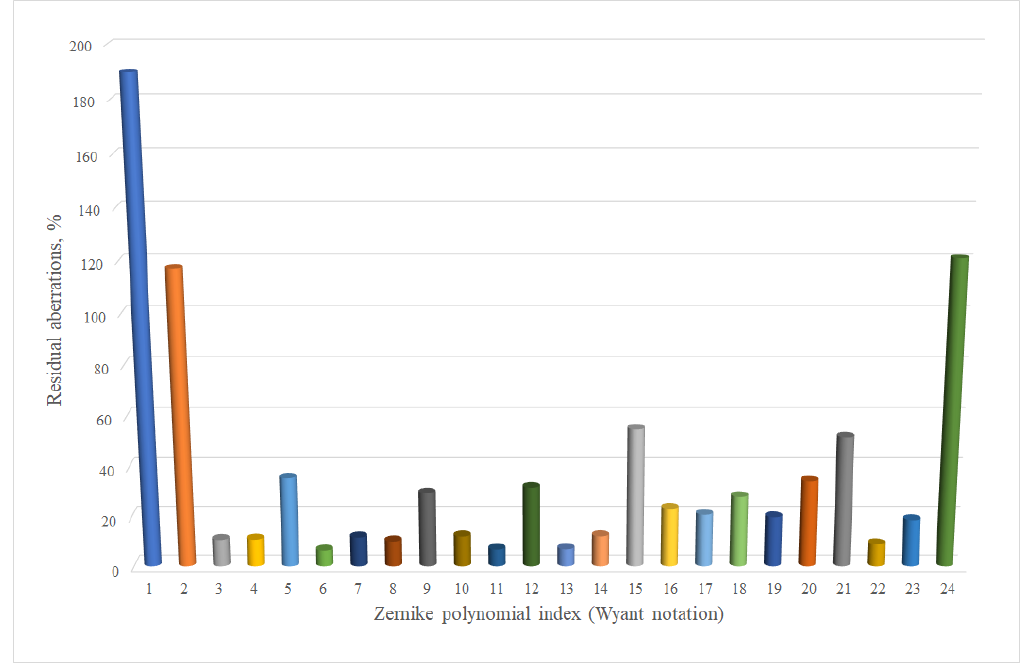
Figure 13. Residual aberrations after correction.